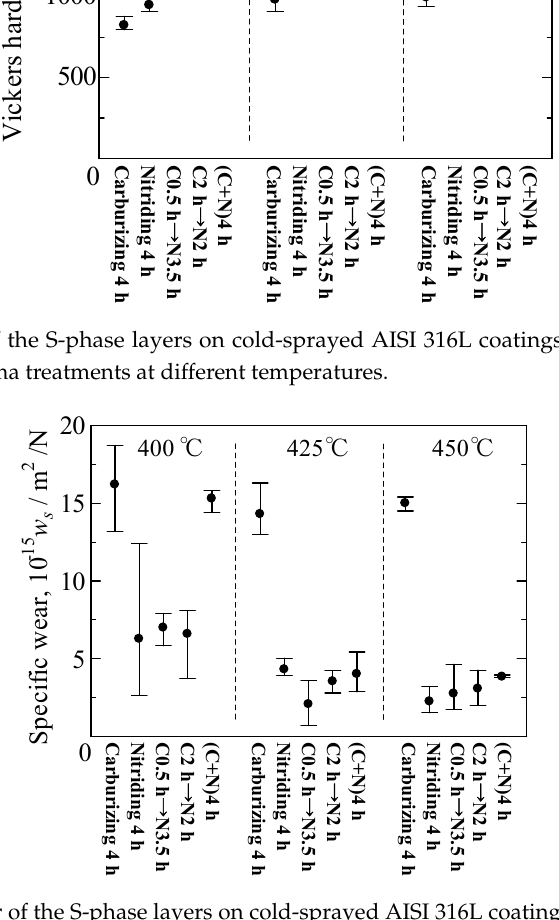
Figure 9. Specific wear of the S-phase layers on cold-sprayed AISI 316L coatings obtained by various low-temperature plasma treatments at different temperatures.